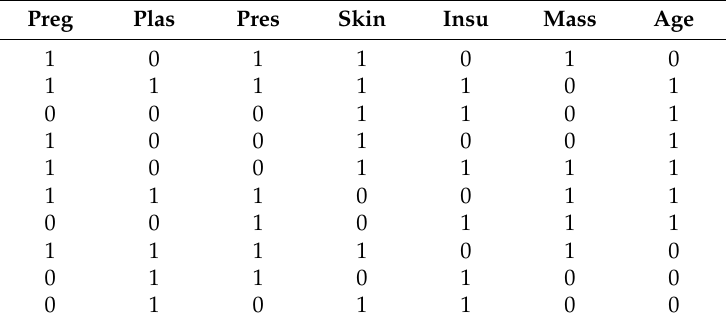
Table 13. Sample Chromosomes are taken at random.